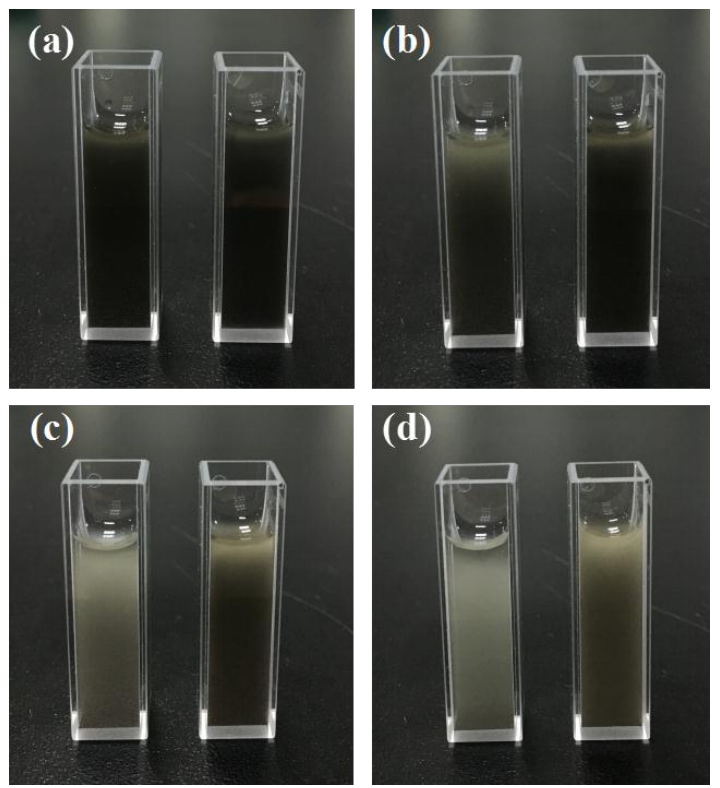
Figure 6. The coagulation condition of Ag nanorod aggregates without adding polyvinyl pyrrolidone (PVP) (left) and with adding PVP (right): ( a ) 0 min; ( b ) 10 min; ( c ) 30 min; ( d ) 80 min.